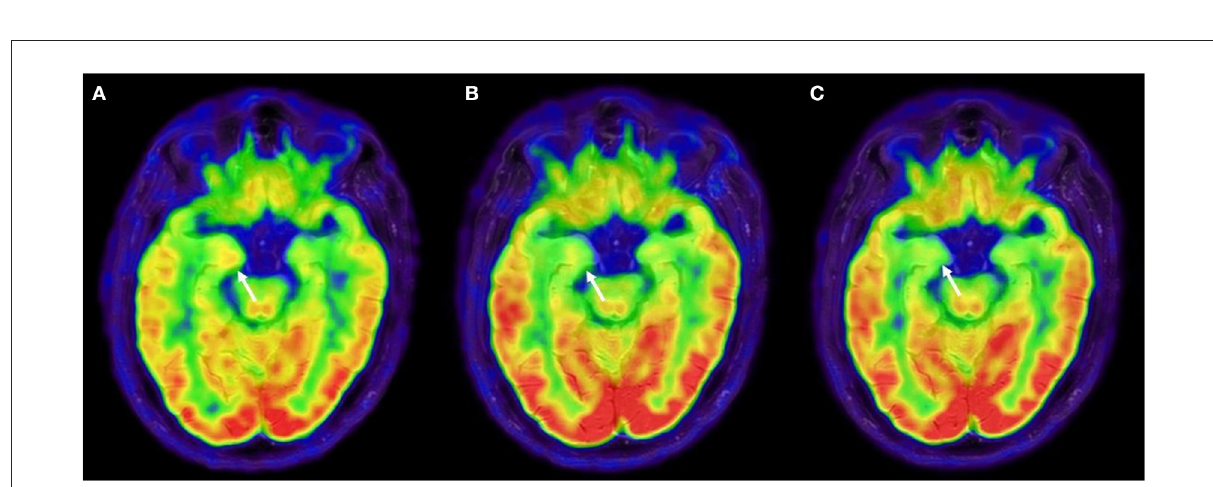
FIGURE2 18F-FDG-PET evolution. (A) 18F - FDG-PET after first-line immune therapy showing moderate right amygdala hypermetabolism and bilateral temporomesial, frontoanterior and frontomesial hypometabolism, suggestive for persistence of disease activity. (B) 18F-FDG-PET was repeated after 3 months from rituximab, showing an attenuation of amygdala hypermetabolism and at 10 months from rituximab (C) , showing a complete regression of the amygdala hypermetabolism. 18F-FDG-PET, 18F-fluoridesoxyglucose-positron emission tomography.